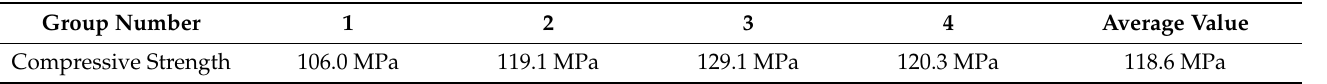
Table 1. Compressive strength test results of parent